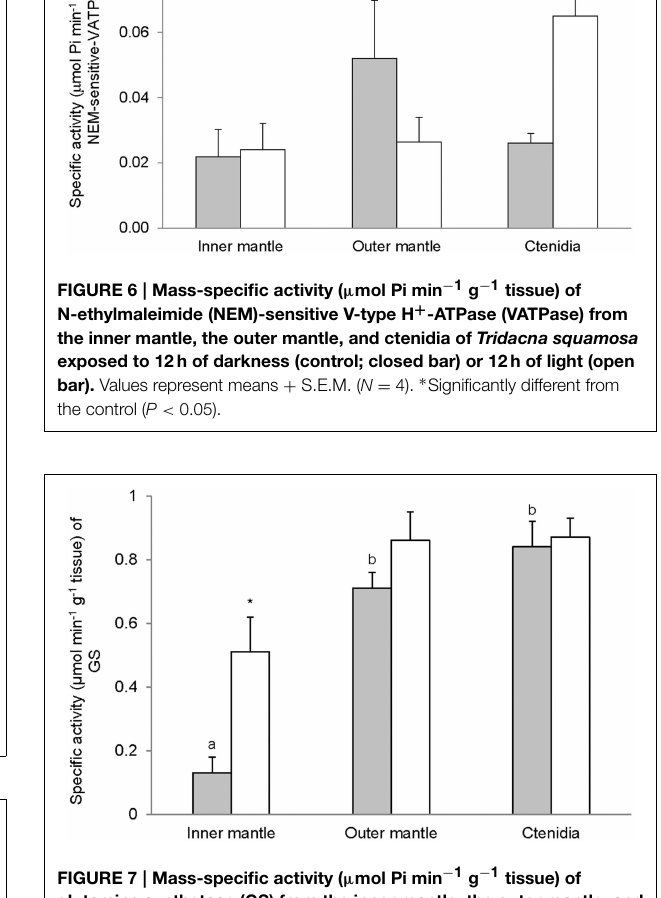
to possible increases in Na + and NH + during light-enhanced